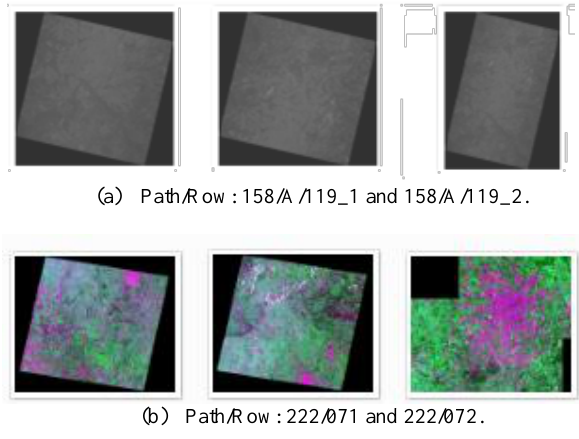
Figure 3 – Image Mosaicking (a) HRC and (b) TM.